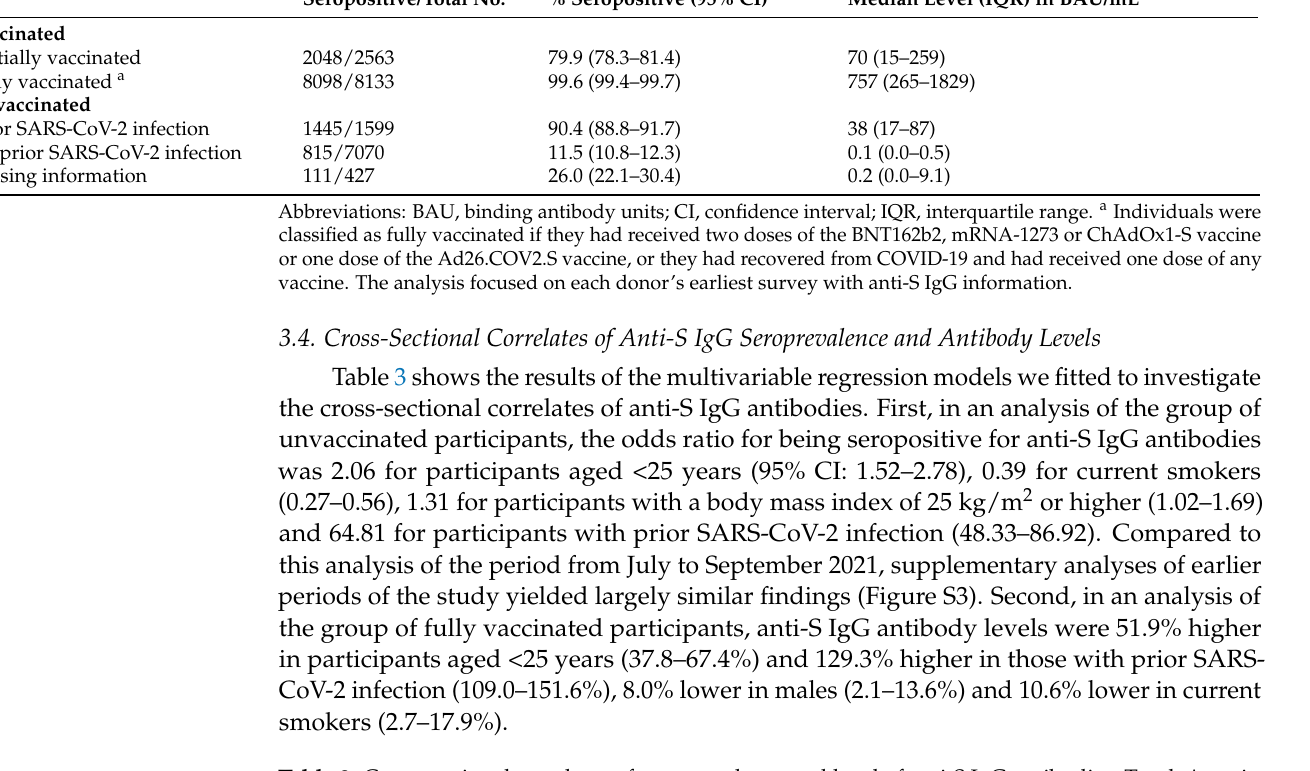
Table 3. Cross-sectional correlates of seroprevalence and level of anti-S IgG antibodies; Tyrol,